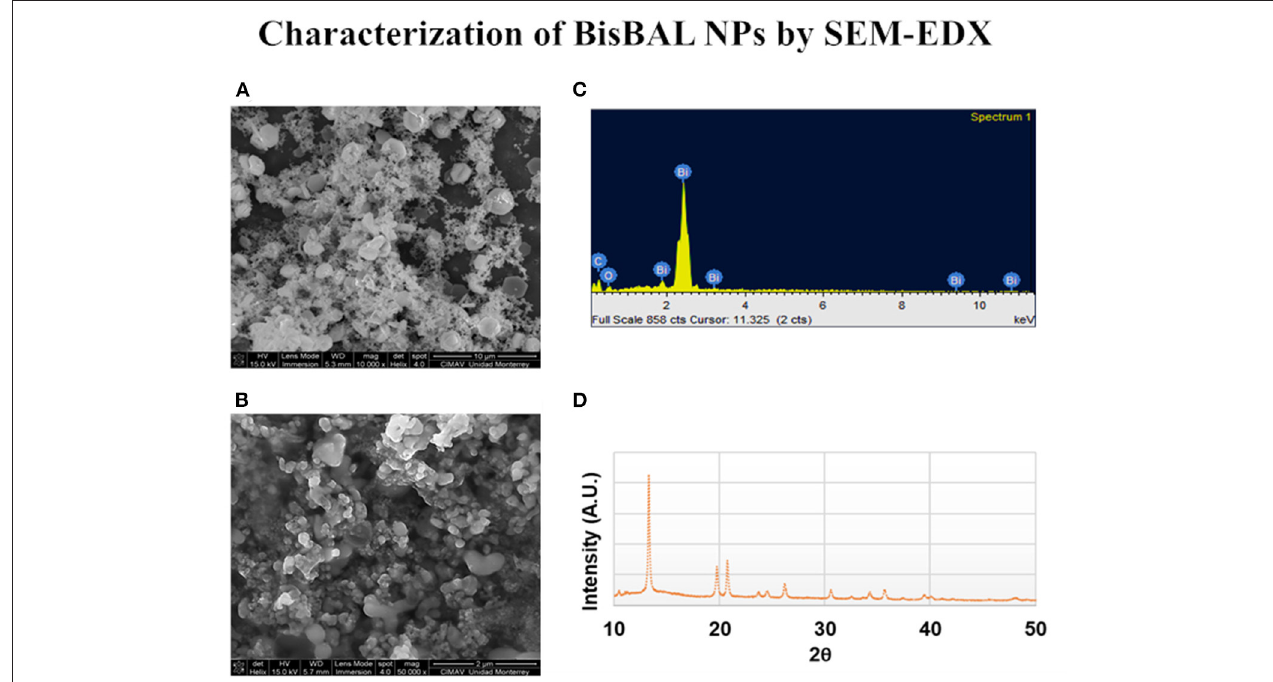
FIGURE 1 | Characterization of BisBAL NPs by scanning electron microscopy (SEM). (A,B) The shape, size, and distribution of BisBAL NPs were obtained by SEM. (C) The specific presence of bismuth was confirmed by energy-dispersive X-ray spectroscopy (SEM-EDS). (D) X-ray diffractometry pattern of BisBAL NPs.